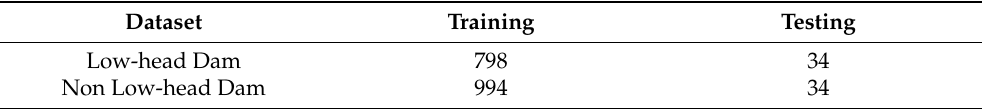
Table 1. Overview of the datasets.